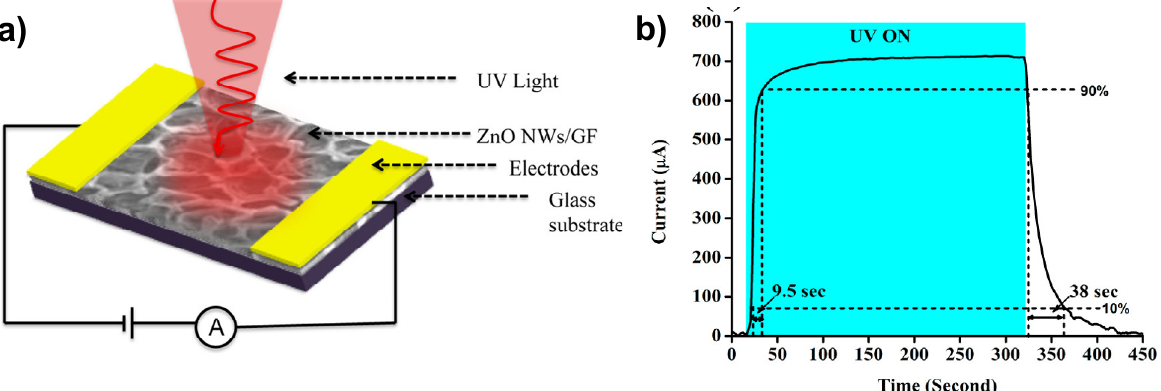
Figure 19. ( a ) Graphic representation of the Zn NW/GF device and ( b ) photo-response of the device at a constant bias voltage of 5 V and UV illumination, indicating the response and recovery time.